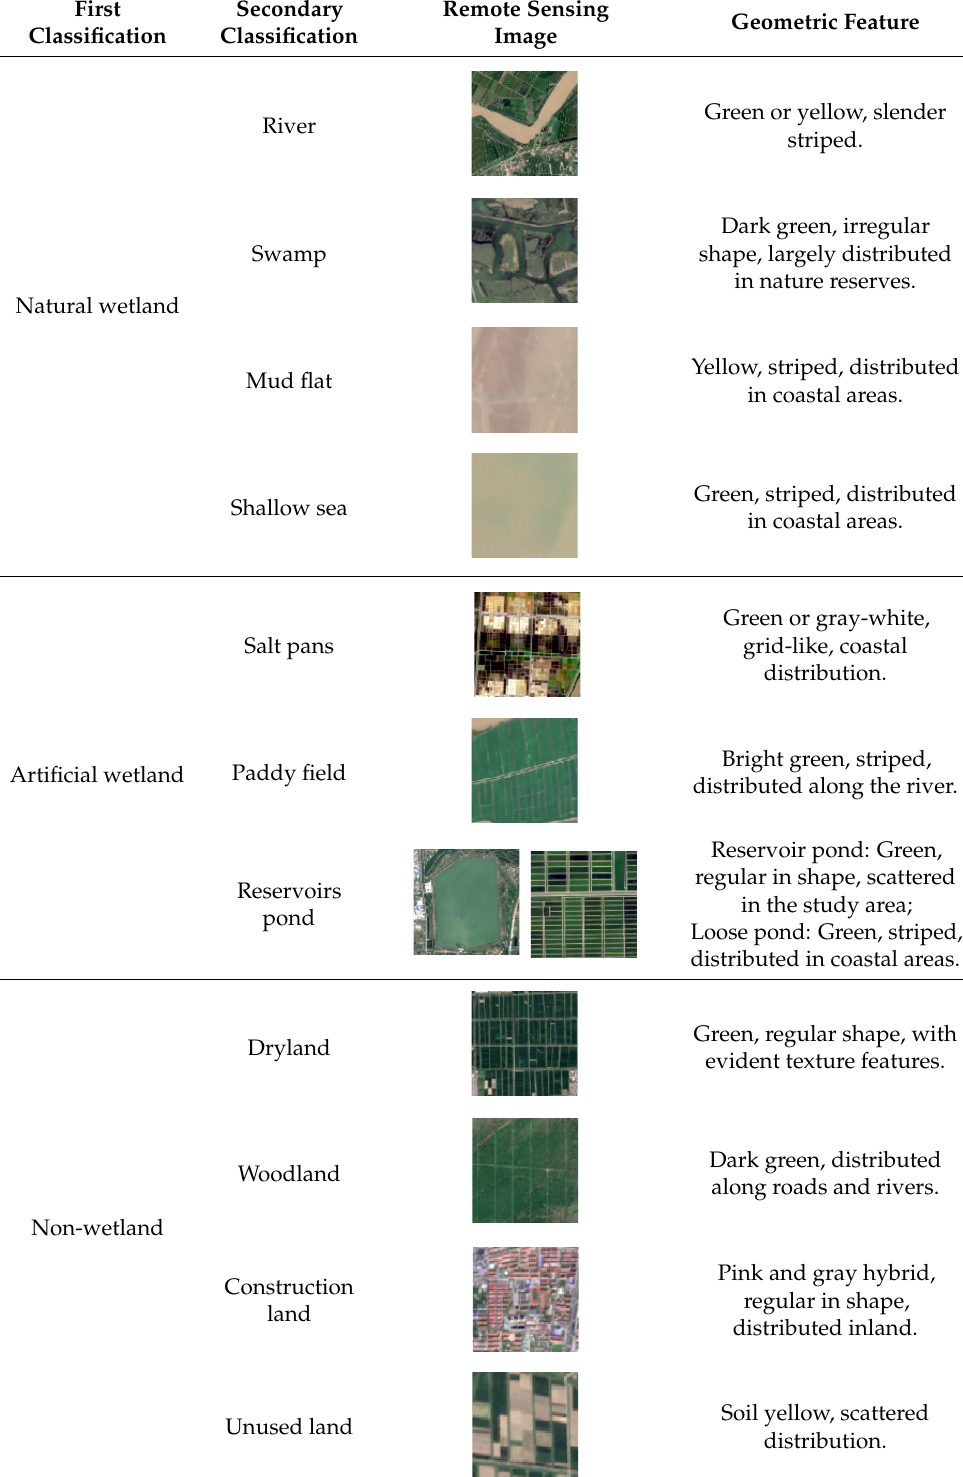
Table 1. Classification system of wetlands in the YRD.